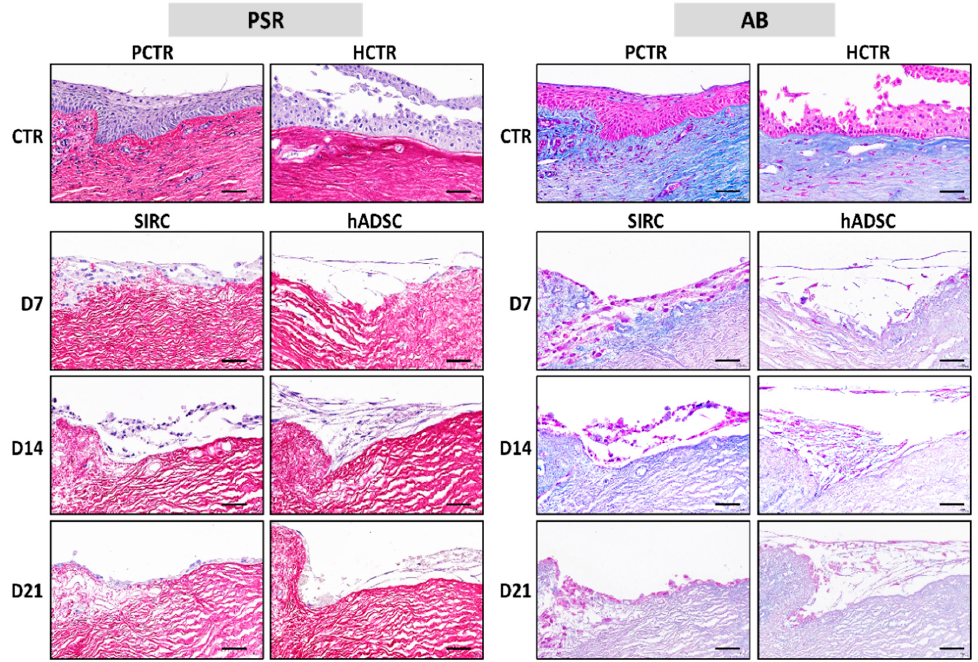
Figure 8. Histochemical analysis of native porcine limbus (PCTR), native human limbus (HCTR), and limbi recellularized with SIRC cells and hADSCs evaluated at days 7 (D7), 14 (D14), and 21 (D21) of follow ‐ up. PSR: picrosirius red, AB: alcian blue. Scale bars: 50 μ m.